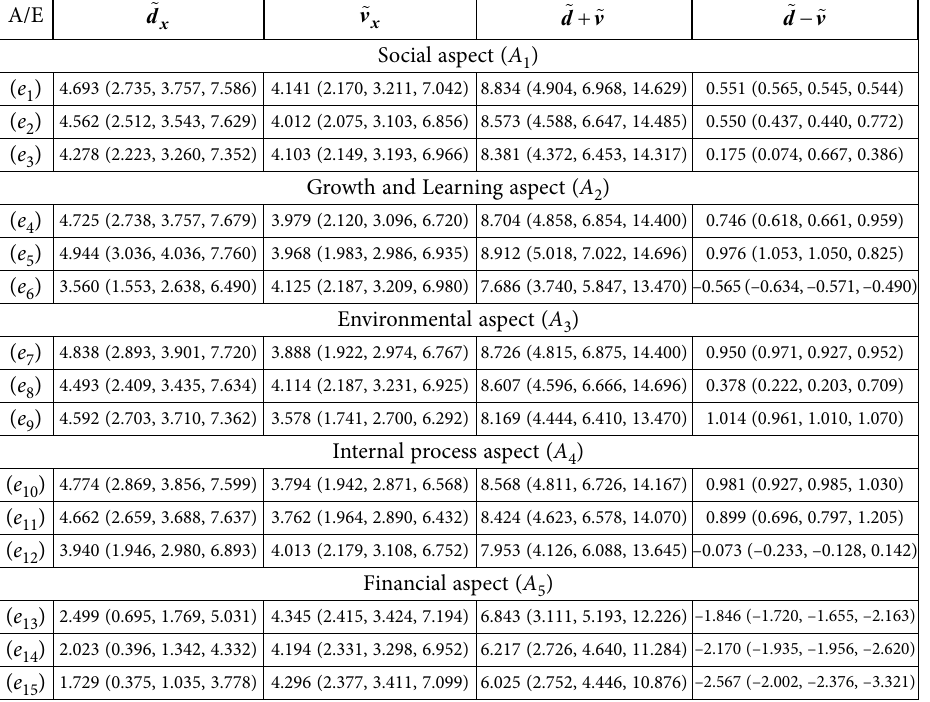
Table 7. sum of effects of each element with fuzzy